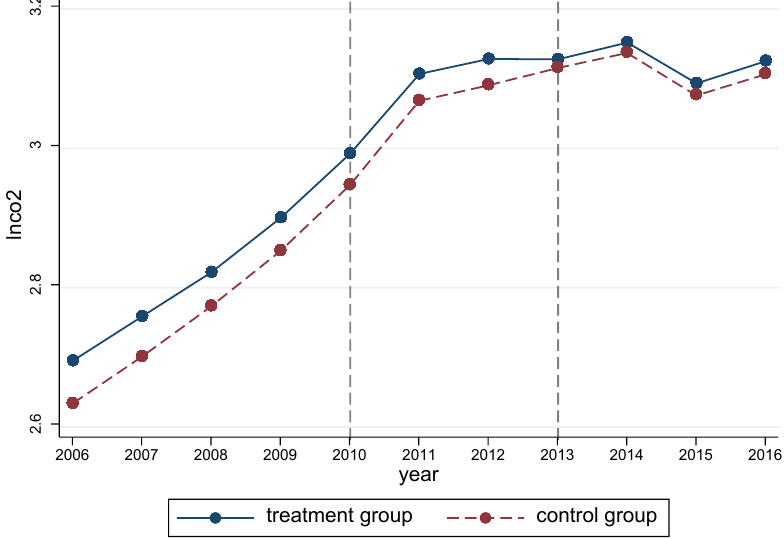
Figure 4. Time series